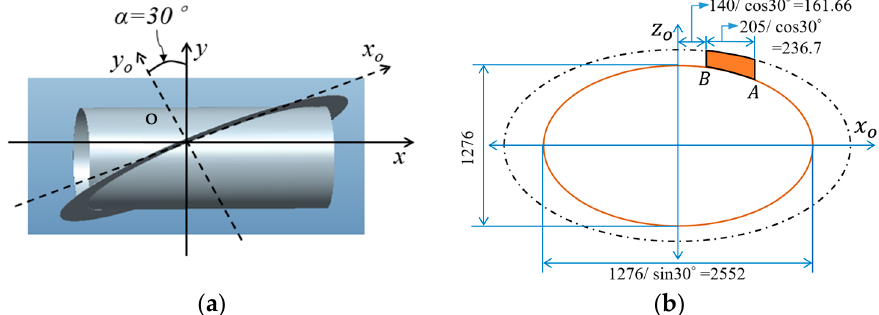
Figure 2. Lug face plate design. (a) Design model illustration, (b) Ellipses of lug working faceplate.